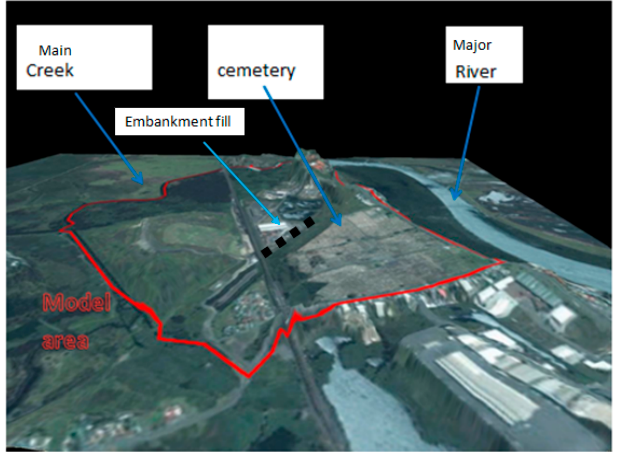
Figure 5. 3-D view of the original model area.